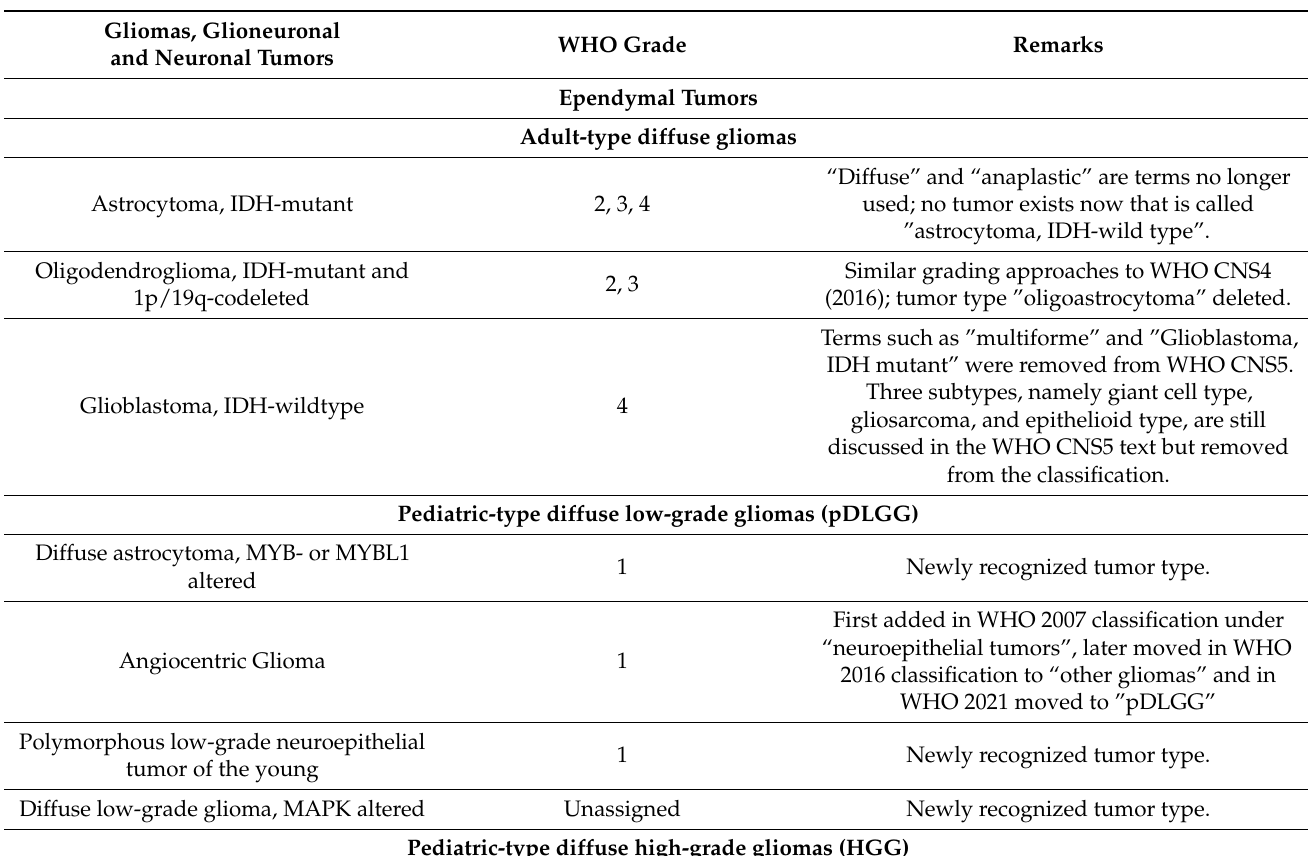
Table 1. Status of gliomas in the fifth edition of the WHO Classification of Tumors of the Central Nervous System (WHO CNS5). Adapted under Creative Commons